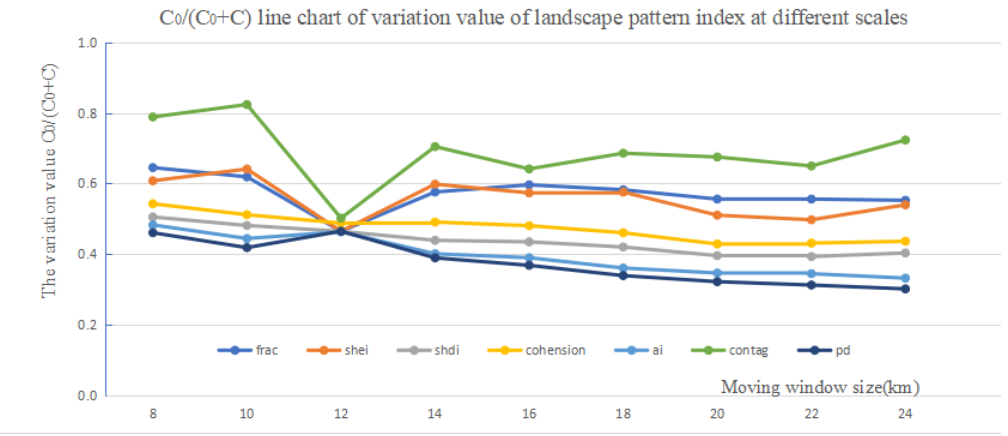
Figure 2. Line chart of variation value of landscape structure factors C 0 /(C 0 + C) for different window